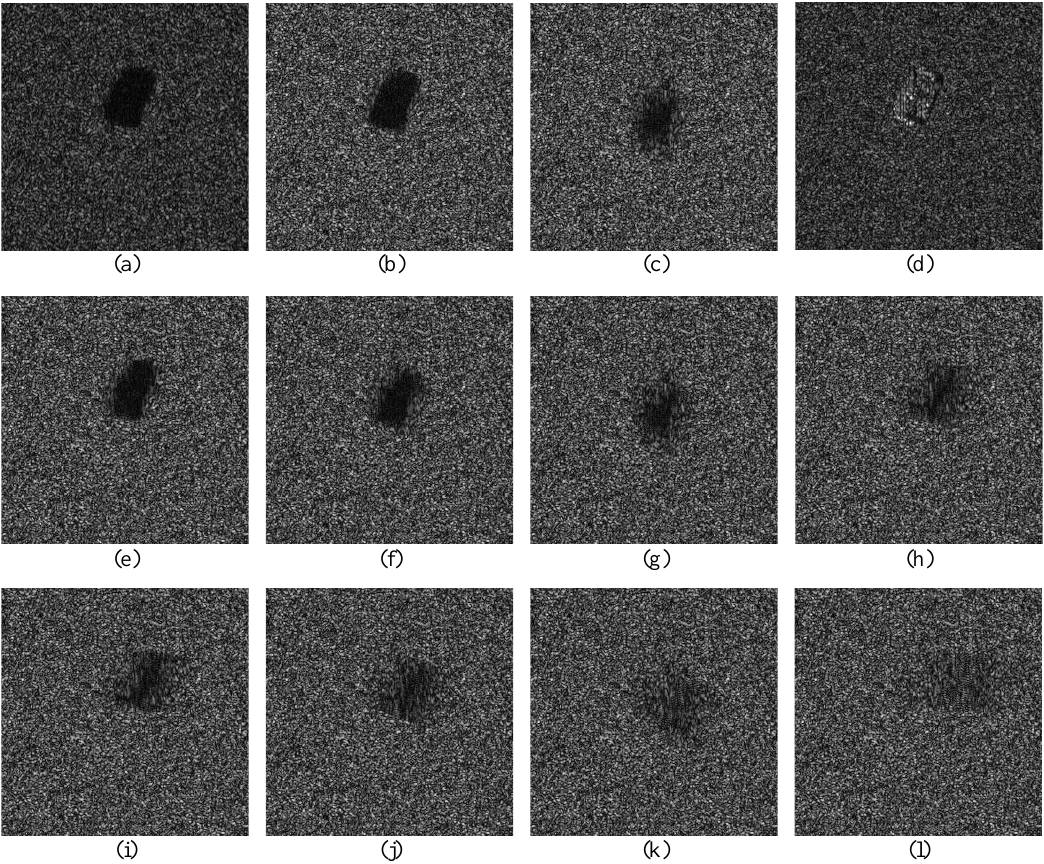
Figure 12. Imaging results of moving target shadow with different speeds (horizontal is azimuth; vertical is range) . The speed of target is ( a ) ( 1 × 0 ) m/s ( b ) ( 1 × 2 ) m/s ( c ) ( 1 × 5 ) m/s ( d ) ( 0 × 1 ) m/s ( e ) ( 2 × 0 ) m/s ( f ) ( 2 × 2 ) m/s ( g ) ( 2 × 5 ) m/s ( h ) ( 5 × 1 ) m/s ( i ) ( 5 × 0 ) m/s ( j ) ( 5 × 2 ) m/s ( k ) ( 5 × 5 ) m/s ( l ) ( 10 × 1 ) m/s. The first is range speed and the second is azimuth